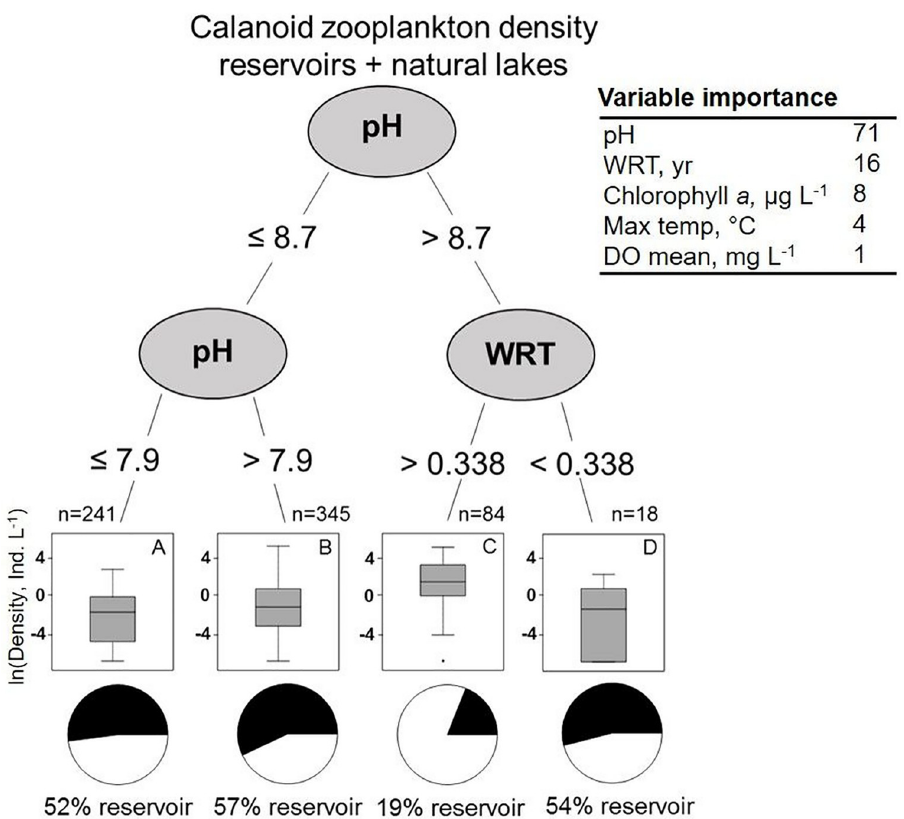
Fig 4. Regression tree analysis for calanoid zooplankton density aggregated across all waterbodies (reservoirs and natural lakes together) in the U.S. In the pie charts, white refers to natural lakes and black refers to reservoirs.